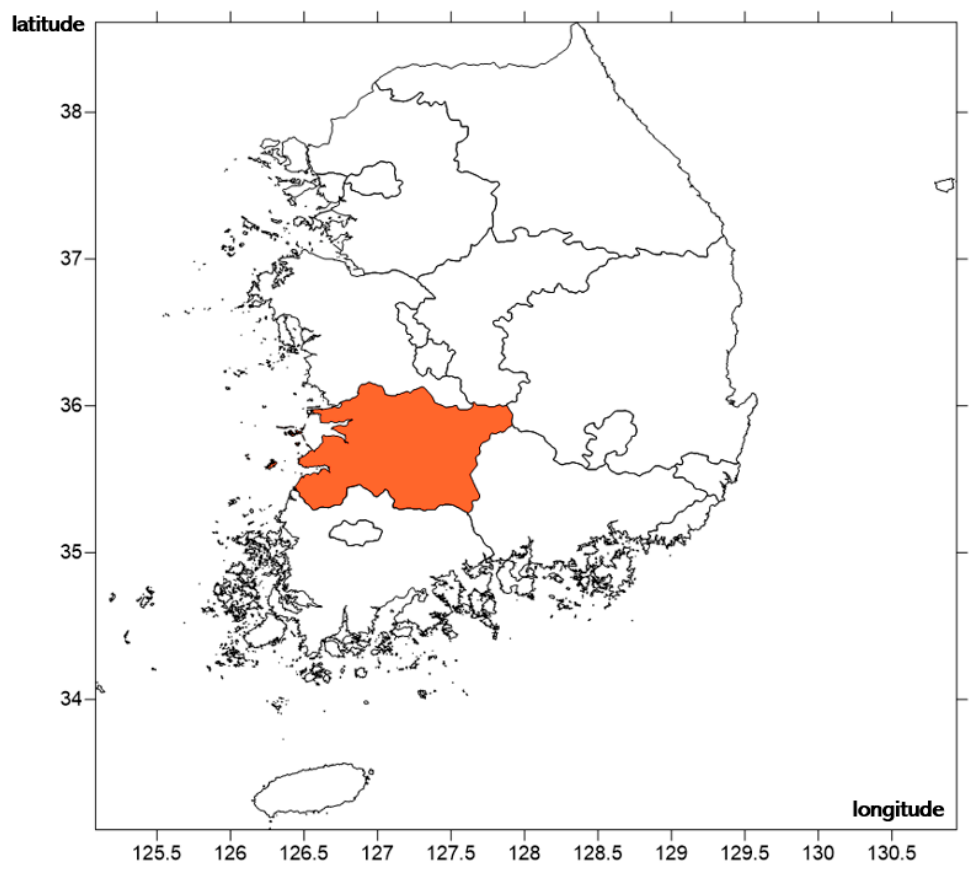
Figure 1. Location of study site (Jeolla Province, South Korea).